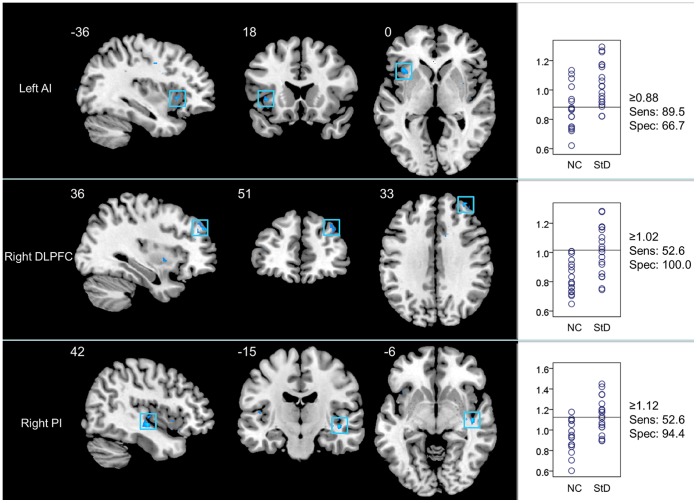
Brain regions (ROIs) showing significantly increased ReHo in StD group (decreased ReHo in NC) (two sample t-test, thresholded at p<0.005 with an extent threshold 5 contiguous voxels, uncorrected) and their sensitivity/specificity plots.The left panel demonstrates the coronal, sagittal, and axial views of each ROI with the MNI location shown at the lower right. The right panel presents correspondingly the scatter plot for the ReHo in the region. Annotations in the figures are identical with those in Figure 2.